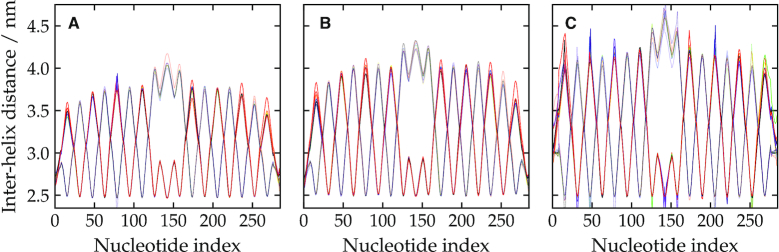
The weave pattern for the 2D tile (A) when the electrostatic term in the model is removed, and at [Na+] = 0.5 M and a temperature of (B) 270 K and (C) 330 K. The data is presented in an analogous way to Figure 3.